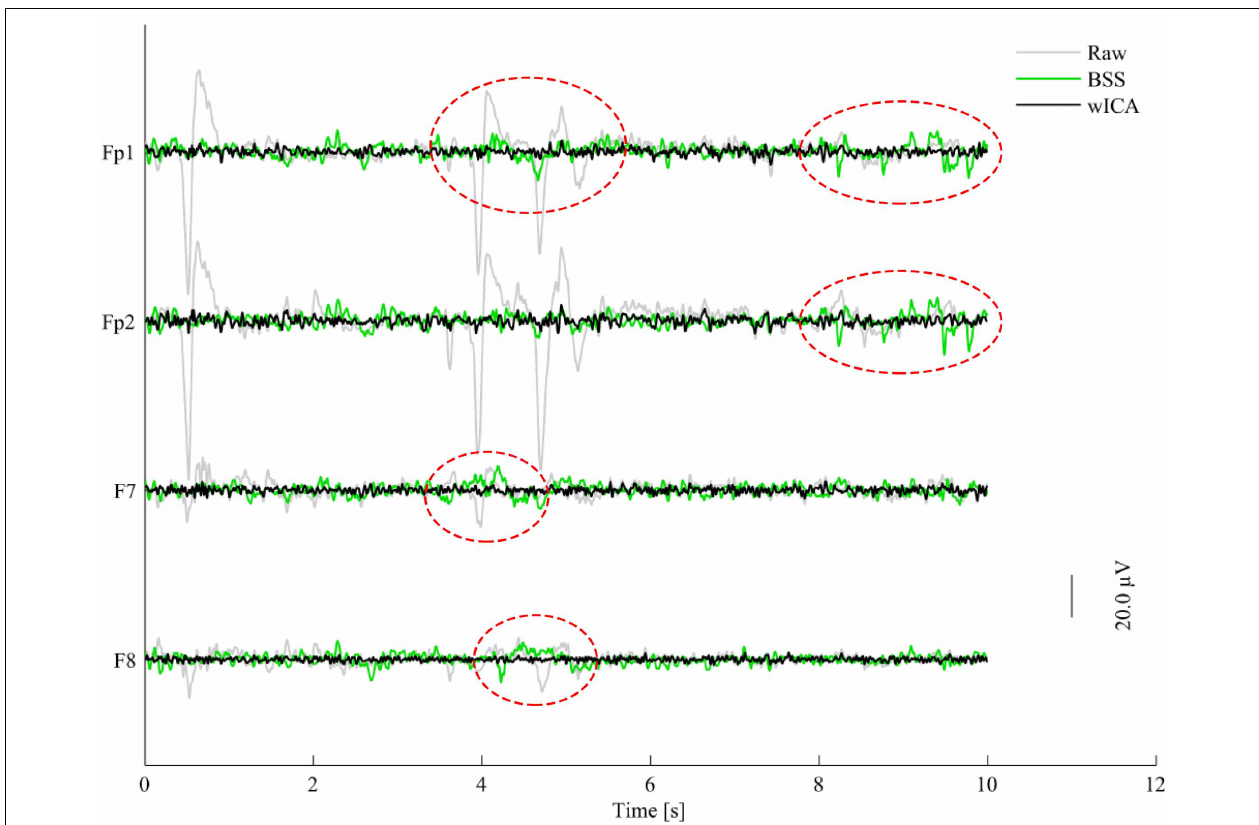
FIGURE 1 | Plots of raw (gray), BSS- (green), and wICA-processed (black) EEG segments for four channels corrupted by eye blinks and